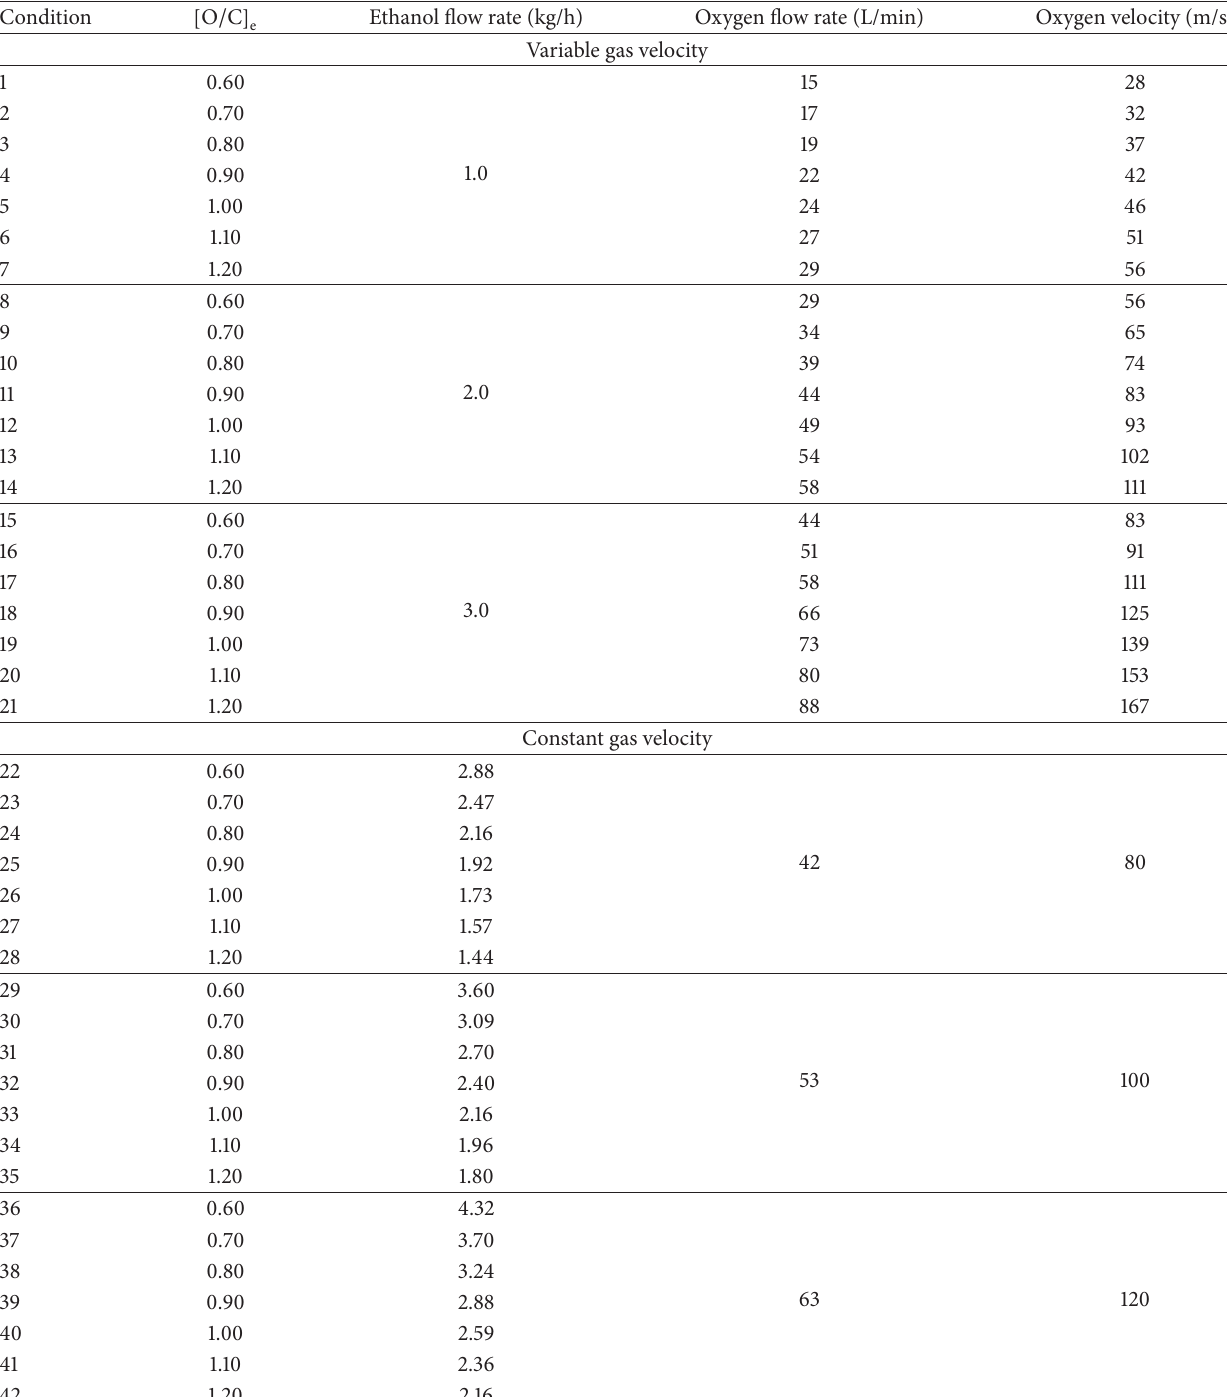
Table 1: Experimental conditions of ethanol